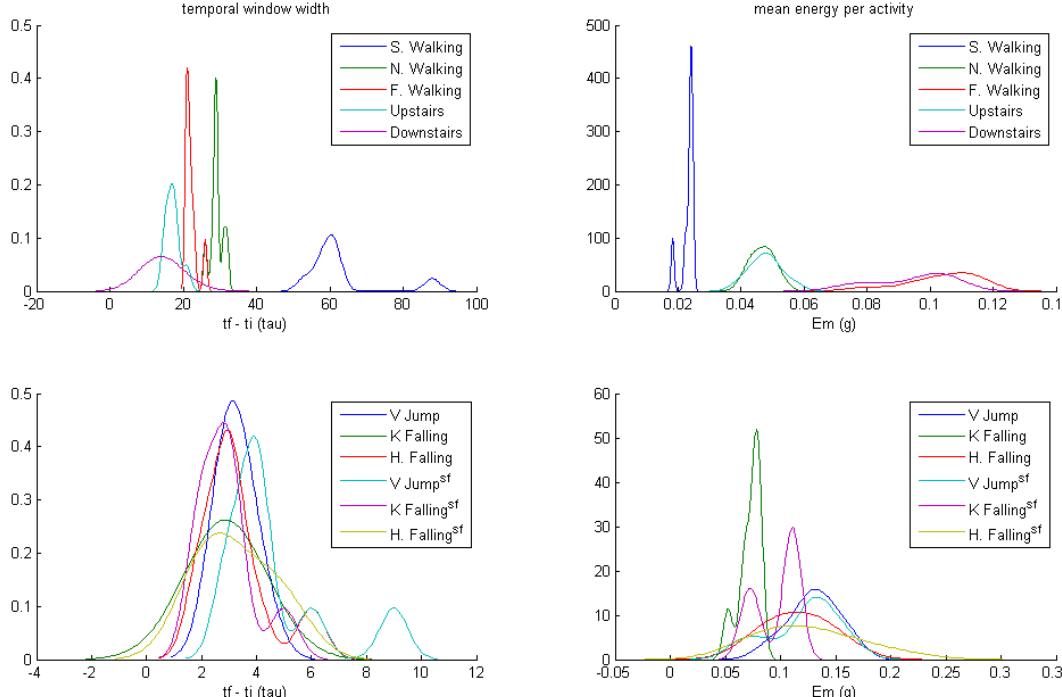
Figure 6. Density plots of temporal window width, and mean energy per type of activity (measured in sensor axis with higher energy), for the personalized study. Top: non-impact activities. Bottom: impact activities. sf Soft